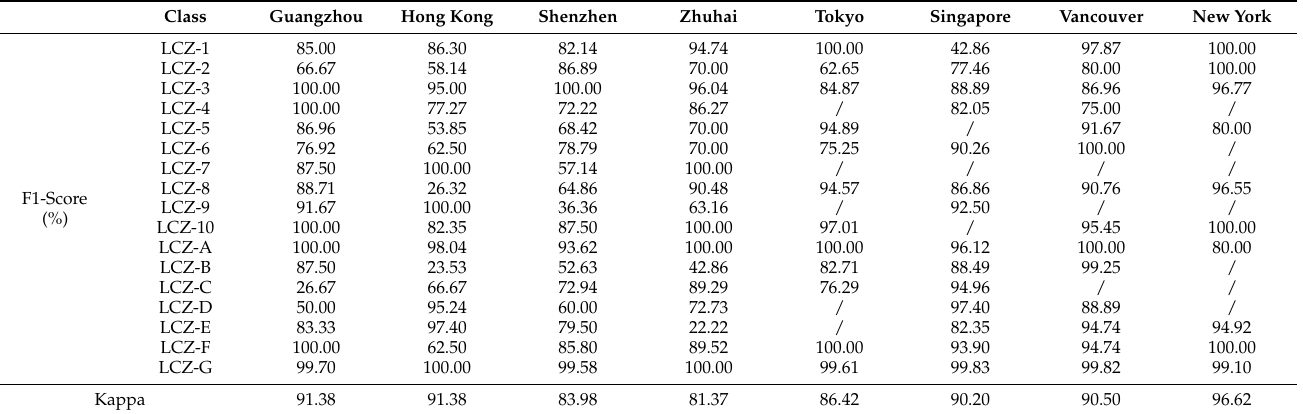
Table 4. The F1-score and Kappa coefficient of LCZ types in test